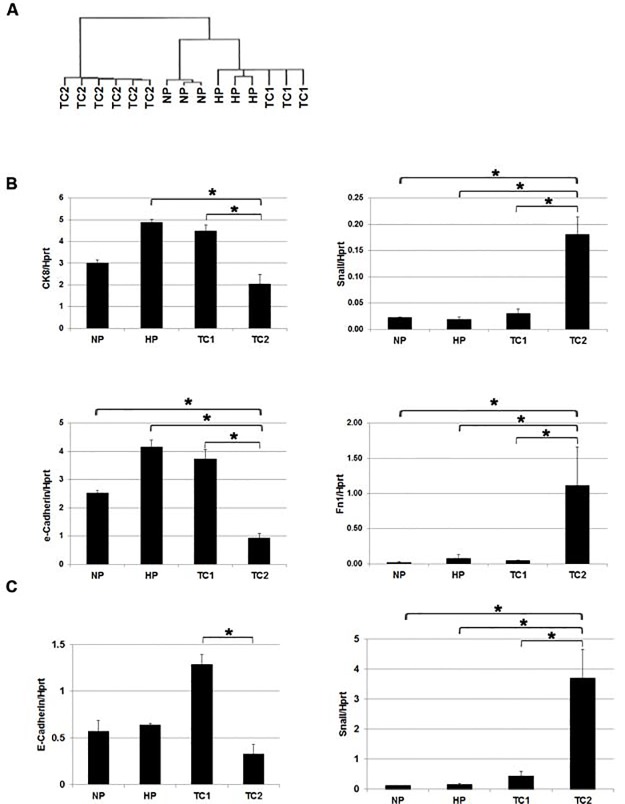
Differential expression of epithelial and mesenchymal markers in TC1 and TC2 tumors.(A) Unsupervised hierarchical clustering of global gene expression data of normal prostates (NP), hyperplastic prostates (HP) and TC1 and TC2 prostate tumors. (B) The relative mRNA expression levels of CK8, E-cadherin, Snail and Fibronectin in NP (n = 3), HP (n = 3), TC1 (n = 3) and TC2 (n = 6) as detected in the expression arrays. Indicated gene expressions were plotted relative to the housekeeping gene Hprt. (C) Representative Q-PCR analysis of Snail and E-cadherin expression. Expression of Hprt was used as Q-PCR reference. Data are presented as mean +/- SE. * p < 0.05, by Mann-Whitney two tailed test.